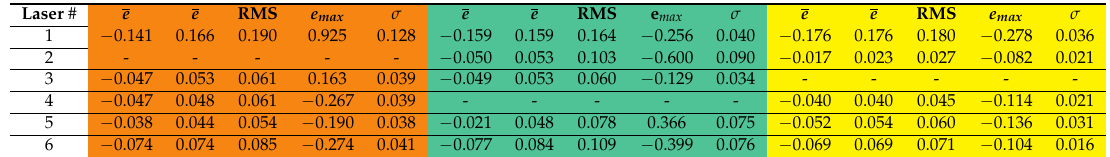
Table 1. Mean error e , mean absolute error standard deviation σ of time errors in seconds. Trial 1 (orange), Trial 2 (green) and Trial 3